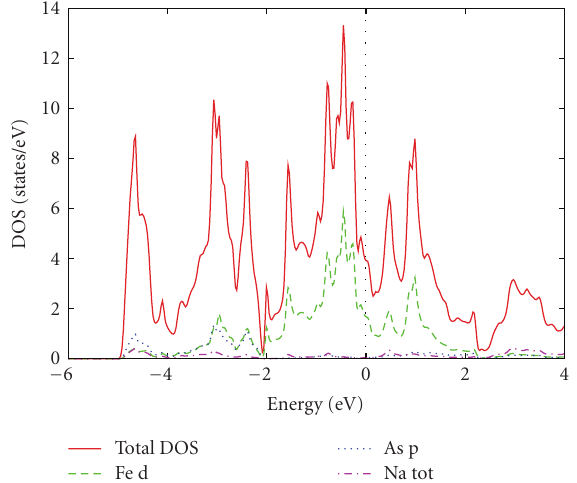
Figure 3: Phonon dispersion curves in LiFeAs, plotted along high symmetry directions of the Brillouin zone.